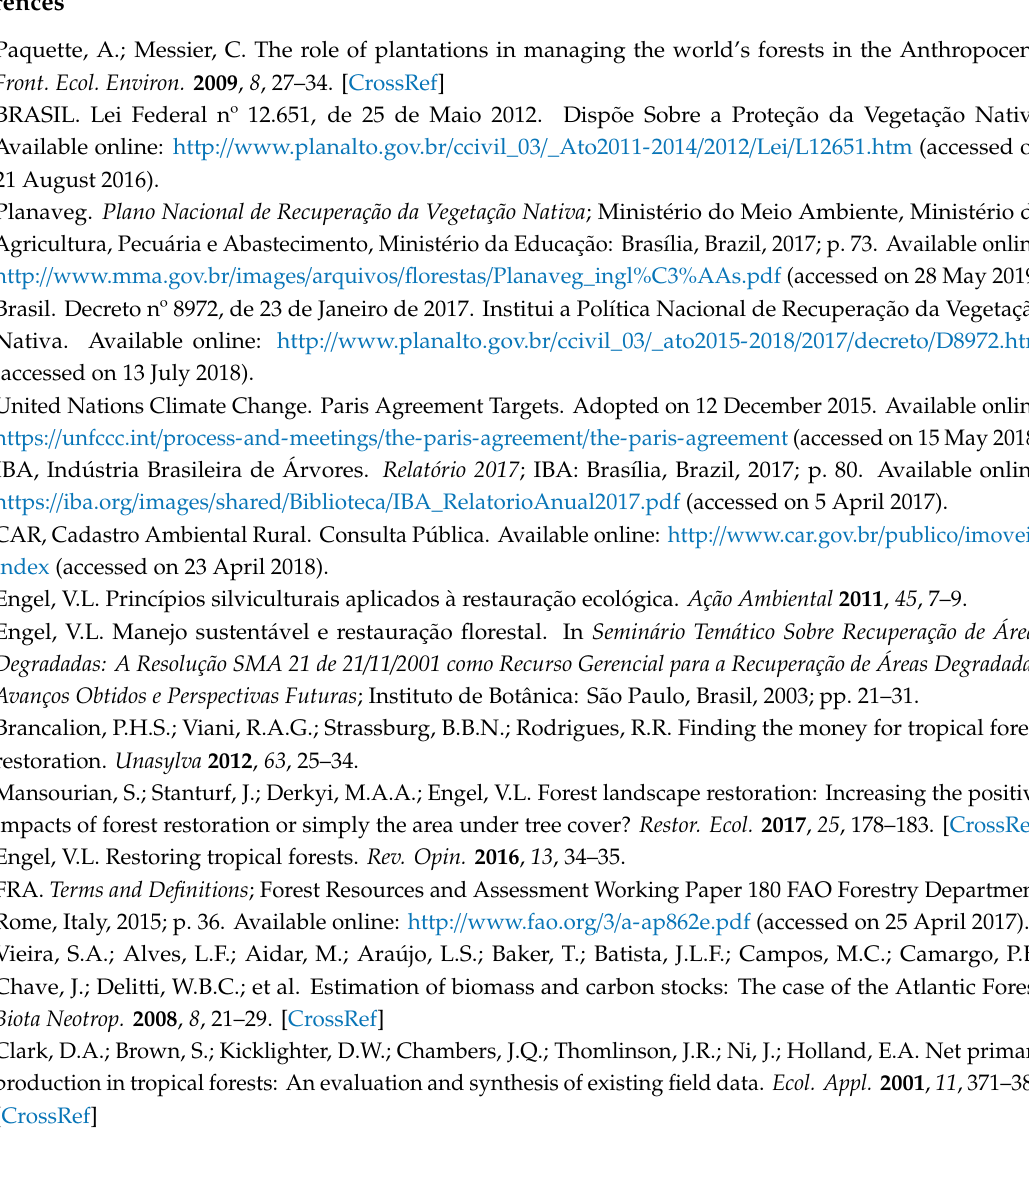
Table S1: List of the composition of the floristic families and species that were originally planted during the installation of di ff erent ecological restoration systems (1997–1998) of the Semideciduous Seasonal Forest in Botucatu, S ã o Paulo; Table S2: List of families and species introduced eight years after establishment as enrichment planting at agroforest system (AFS) plots with fruit species at Ultisol and medicinal species at Alfisol; Table S3: List of the floristic composition of the families and species sampled 20 years after establishment in the ecological restoration systems of the Semideciduous Seasonal Forest in Botucatu, S ã o